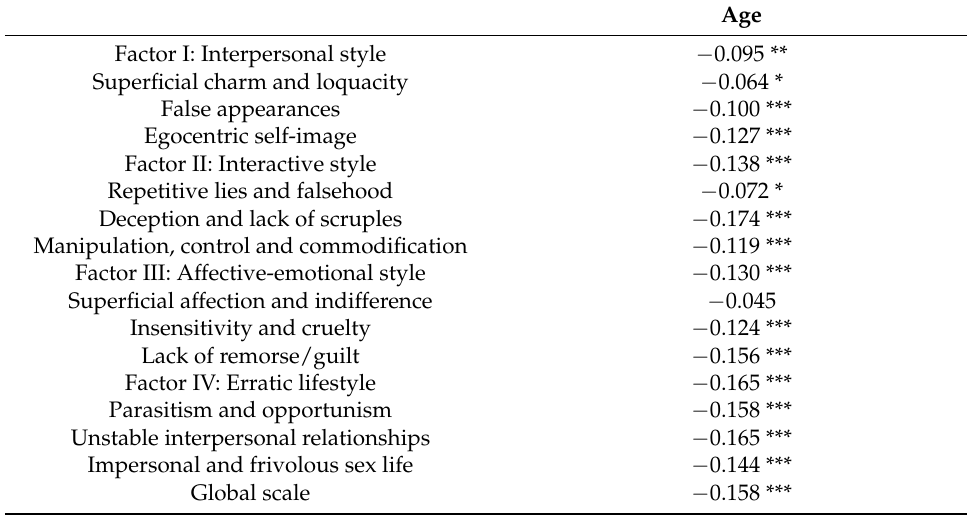
Table 3. Correlation between subclinical psychopathy and age.